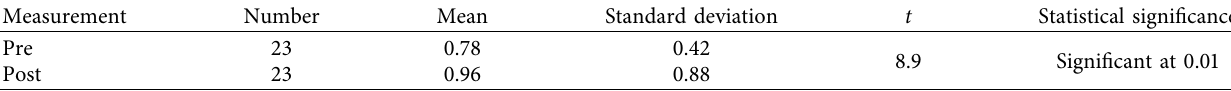
Table 9: The results of the t -test and the significance of the differences for the two measurements, pre and post, for the experimental group in the test of reading comprehension skills at the critical comprehension level.